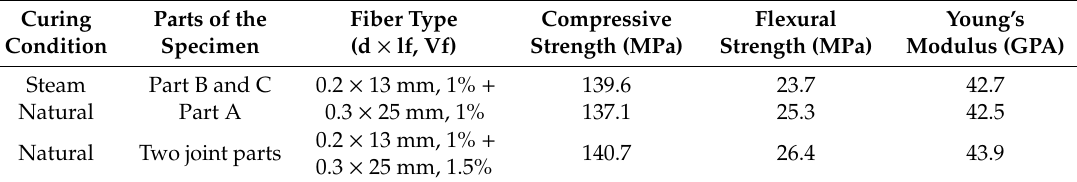
Table 2. Mechanical properties of UHPC.